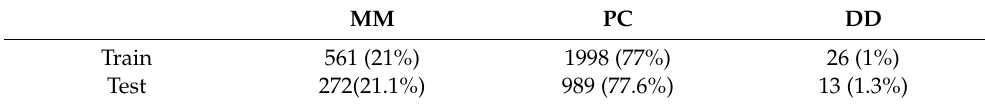
Table 4. The number of different actions present in test and train datasets.